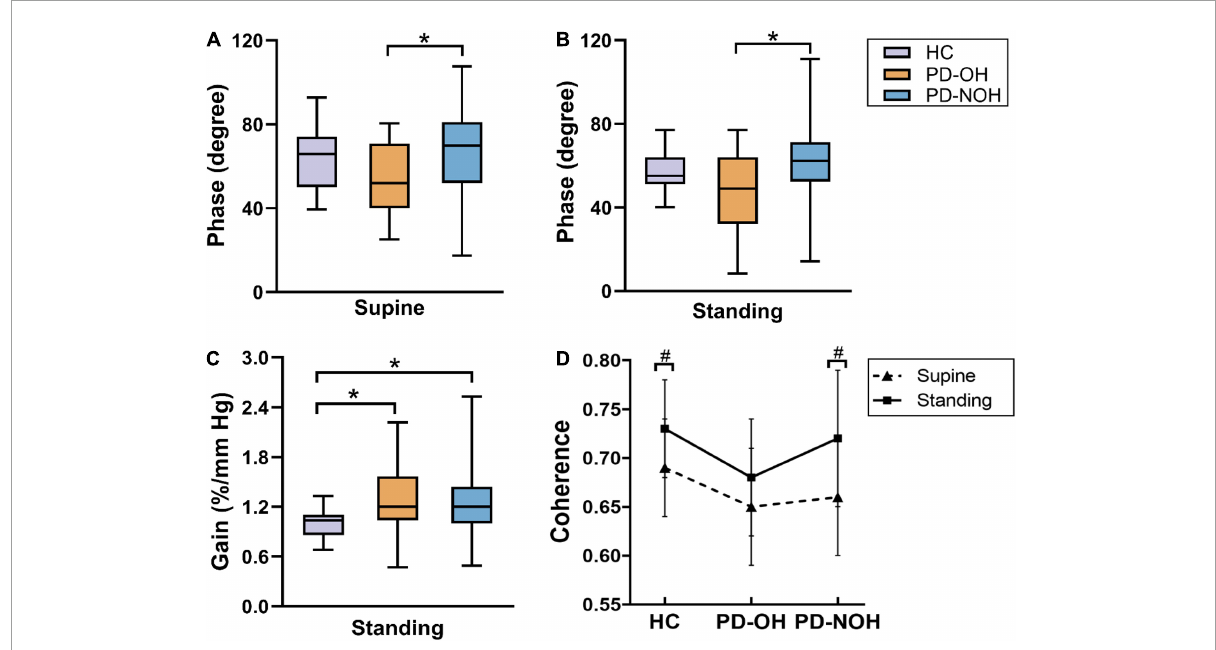
FIGURE1 Comparison of autoregulation parameters between groups in VLF. (A,B) The phase difference from the PD-OH group is significantly lower than that of PD-NOH on both body postures. (C) During standing, there is significant difference in normalized gain between three groups. (D) The coherence of the standing position is higher than that of the supine in PD-NOH and HC. *Indicates P < 0.05; # Indicates P < 0.05 for comparison with supine; The whiskers in subplots (A–C) indicate the data range, and the error bars in subplot (D) indicates standard deviation. Eighty-nine PD patients and 20 HC in supine, 83 PD patients, and 20 HC in